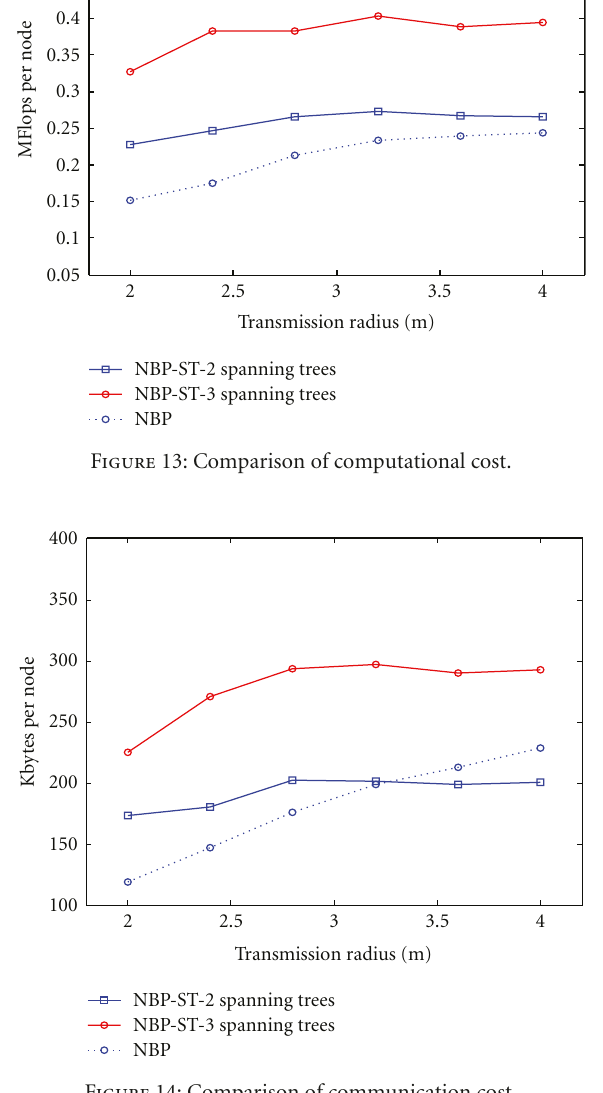
Figure 14: Comparison of communication